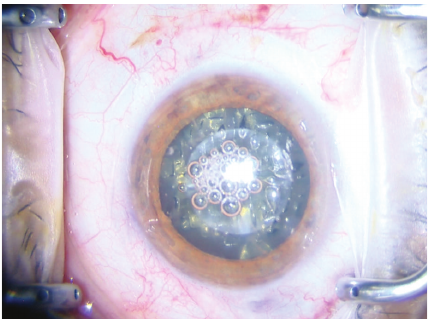
Figure 4: Surgeon view of eye after femtosecond laser capsulotomy lens softening and limbal relaxing incision with the Catalys